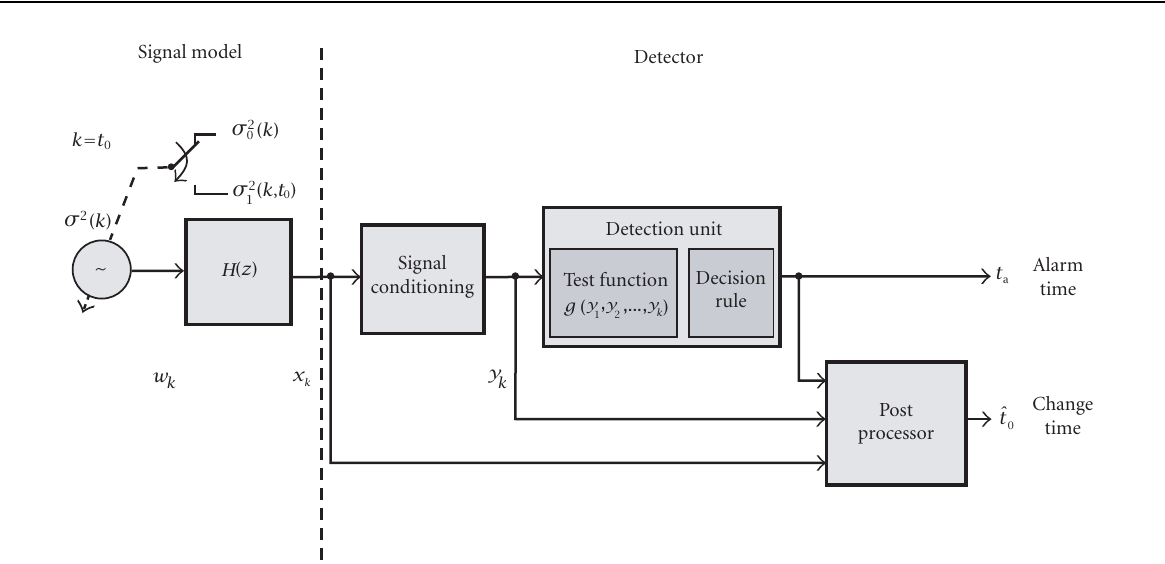
Figure 1: Scheme of event detection in surface electromyographic signal (SEMG). The digitized SEMG x k is modeled by a white Gaussian noise signal with dynamic variance σ 2 (k) exciting a linear system with transfer function H(z) . At t 0 ,the signal variance changes from resting activity σ 2 0 (k) to σ 2 1 (k,t 0 ) of the active state. Most detectors employ up to three processing stages (signal conditioning, detection unit,